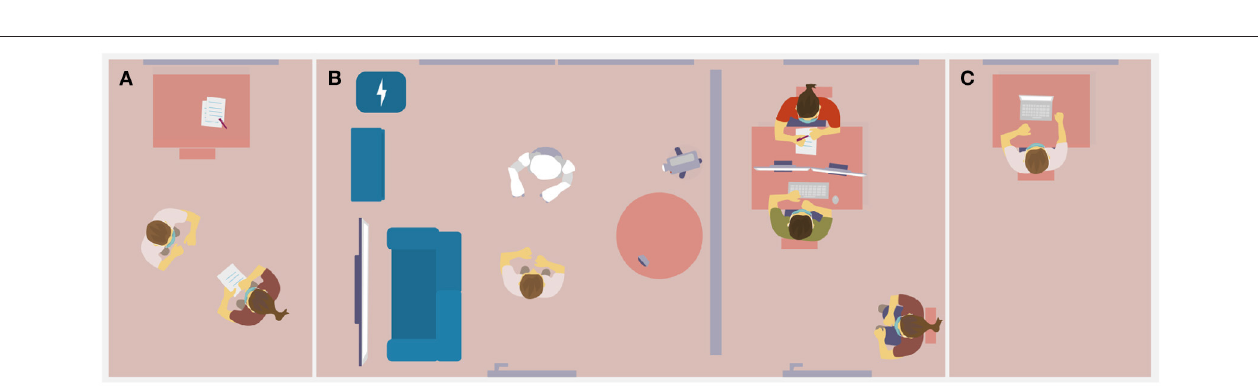
FIGURE 8 | A sequence diagram showing the interaction between different components of the architecture to initiate a Strategy (high-level socio-interactive behavior) and simultaneously extract the information necessary for explaining this behavior (Requirement 4).